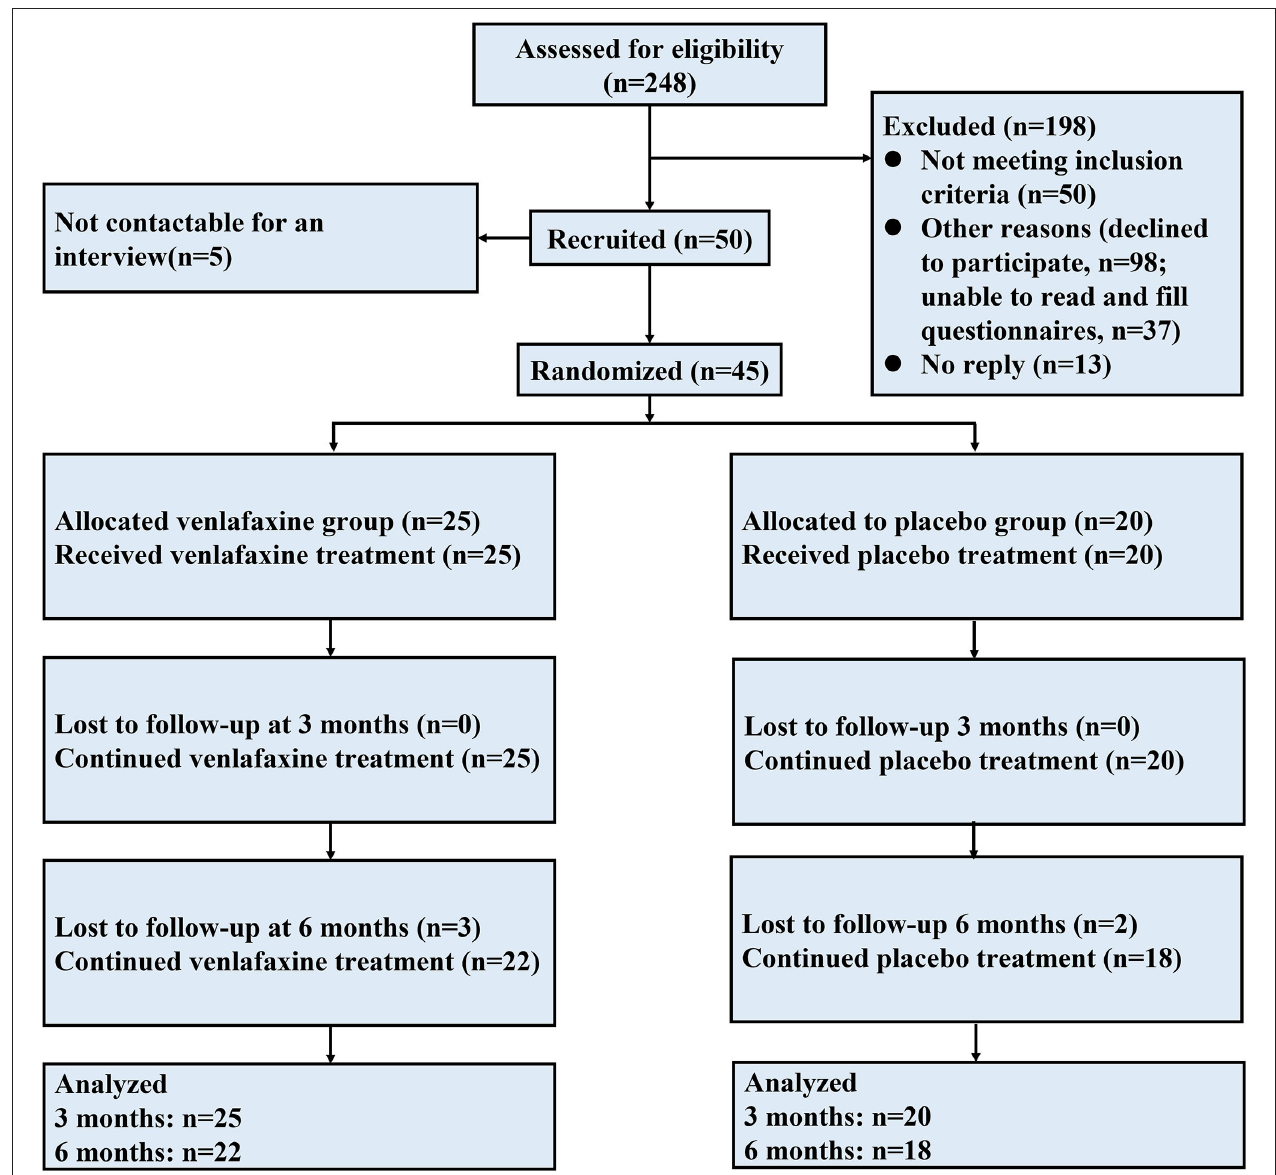
FIGURE 1 | Flowchart of the